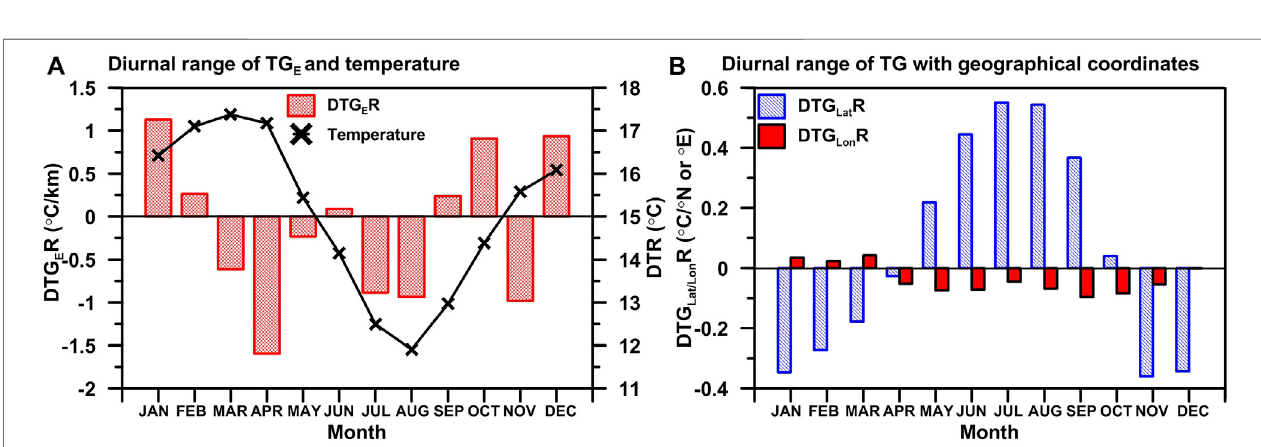
FIGURE 11 | Variation in the diurnal temperature range and its gradient with elevation (A) and geographical coordinates (B) in the study region.